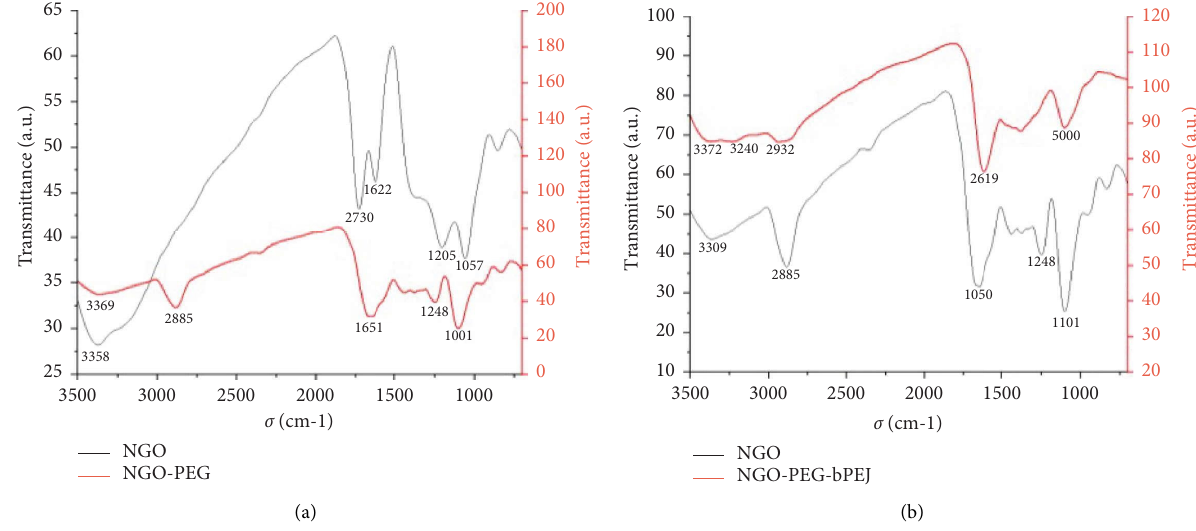
Figure 2: FTIR spectra of NGO and NGO-PEG (left), and FTIR spectra of NGO-PEG and NGO-PEG-BPEI (right). (a) Te absorption peaks of NGO are 3377cm − 1 and 1730cm − 1 , and the absorption peaks of NGO-PEG are 3375cm − 1 , 1653cm − 1 , 2874cm − 1 , and 1099cm − 1 ; (b) the absorption peaks of NGO-PEG are 3375cm − 1 , 1653 cm − 1 , 2874cm − 1 , and 1099cm − 1 , and the absorption peaks of NGO-PEG-BPEI